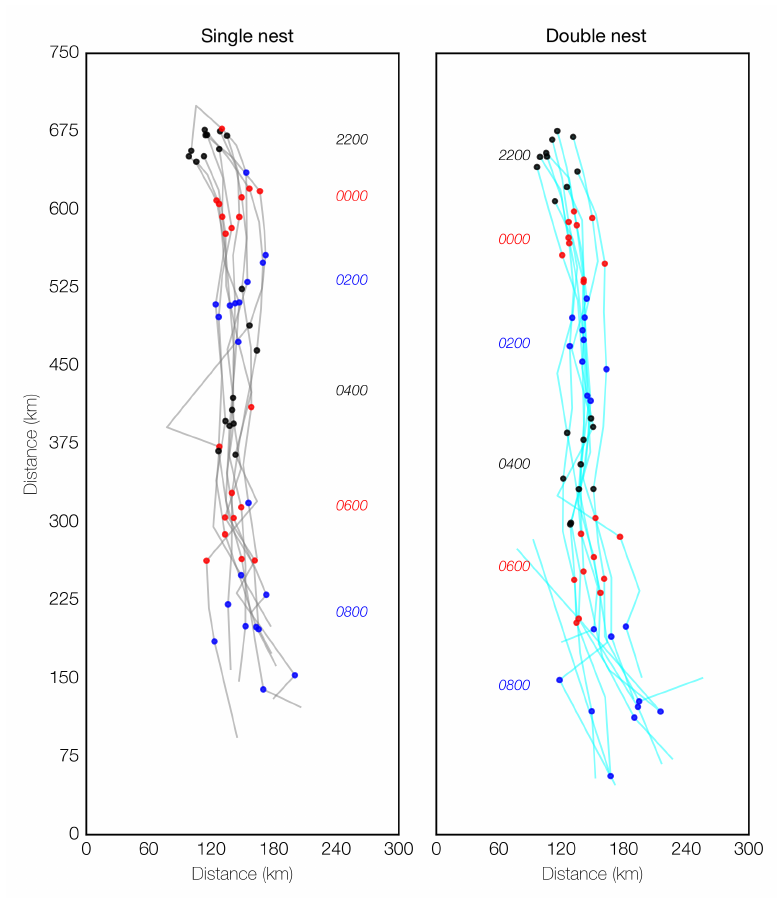
Figure 8. Paths taken by the centroids of the MCS in each ensemble member for the single- ( left ) and double-nest ( right ) EPSs between 2200UTC on Day 1 (22h) and 0800UTC on Day 2 (32h). The centroid position is marked every two hours for each ensemble member by a dot. The color corresponds to the labeled time stamps, which are positioned at the ensemble-mean north-south position. Hence, locational spread is represented by a larger distance between dots of the same